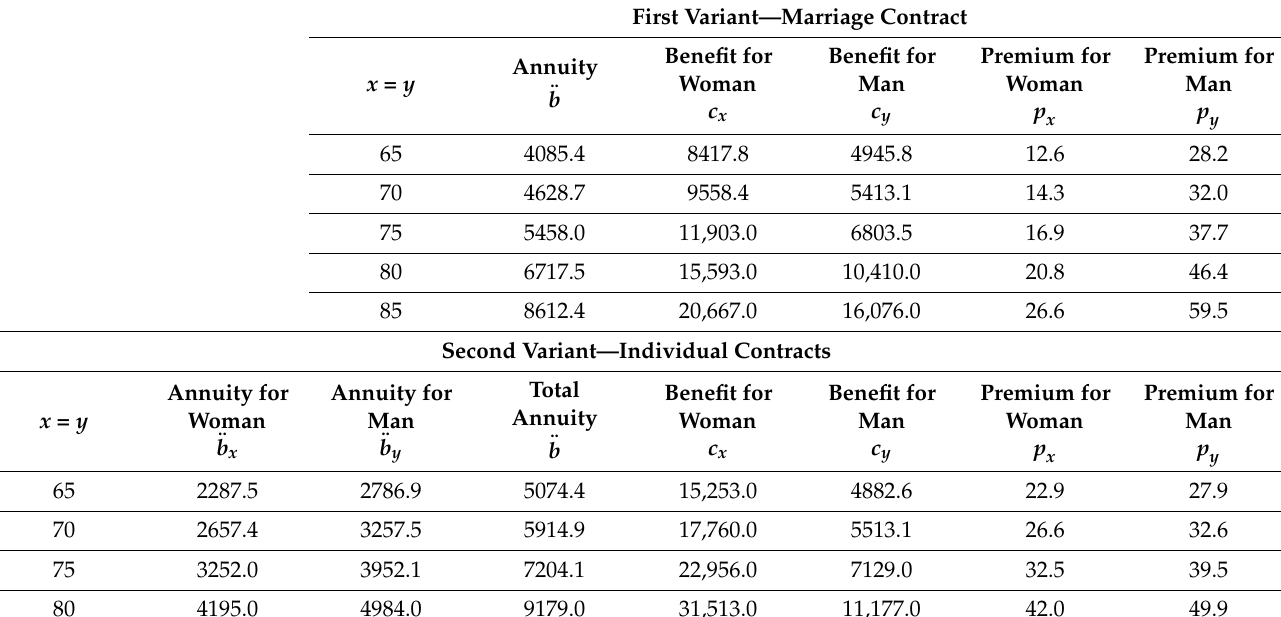
Table 3. Cash flows in two variants of equity